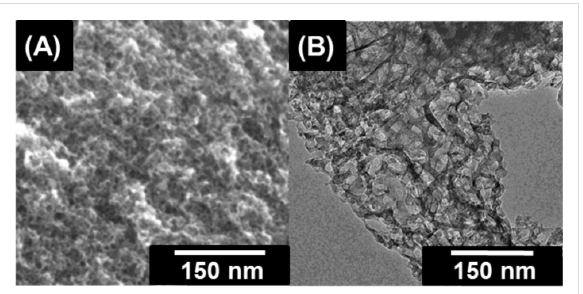
Figure 3: SEM (A) and TEM (B) images of the Carb-SF-3